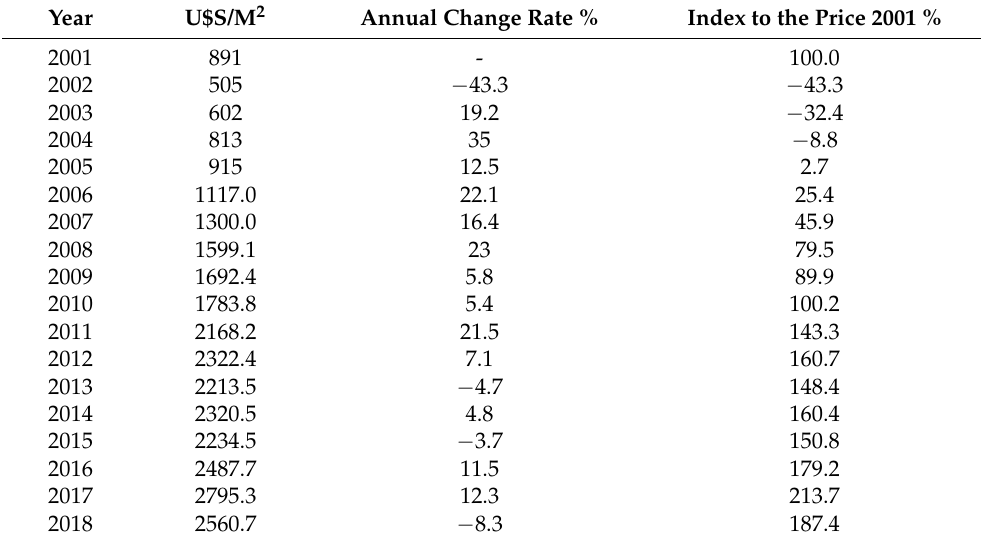
Table 2. Average land price in the CBA, 2001–2018. Data from DGEyC [48]. Year U$S/M